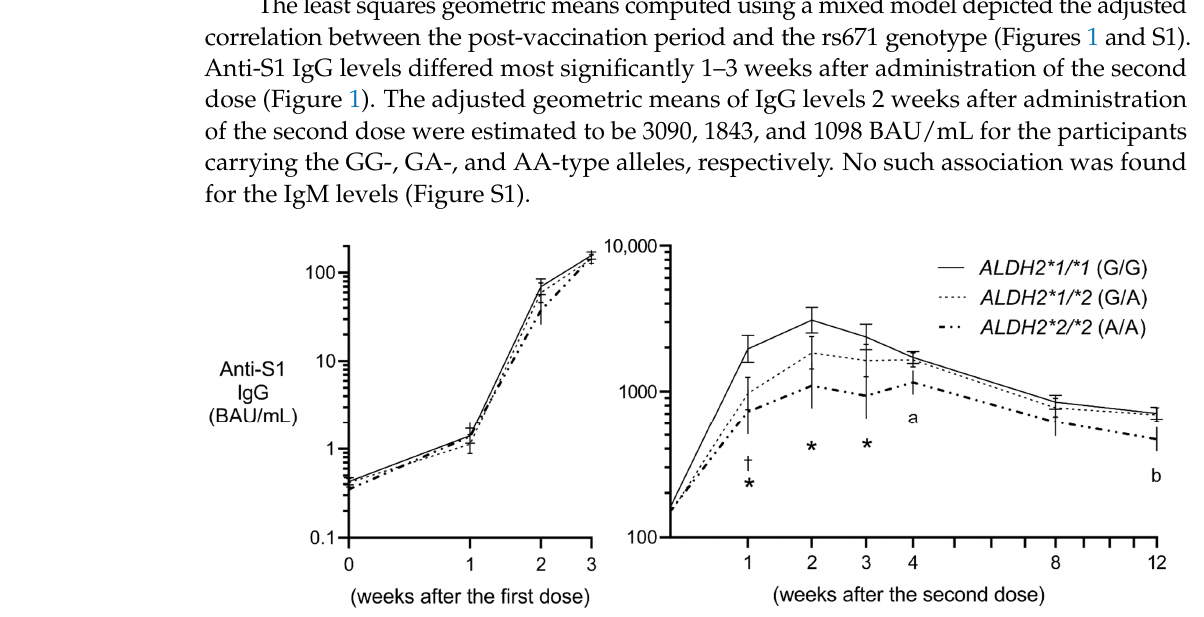
Table 3. Estimated fixed effects of baseline characteristics on log-transformed anti-S1 IgG, BAU/mL.